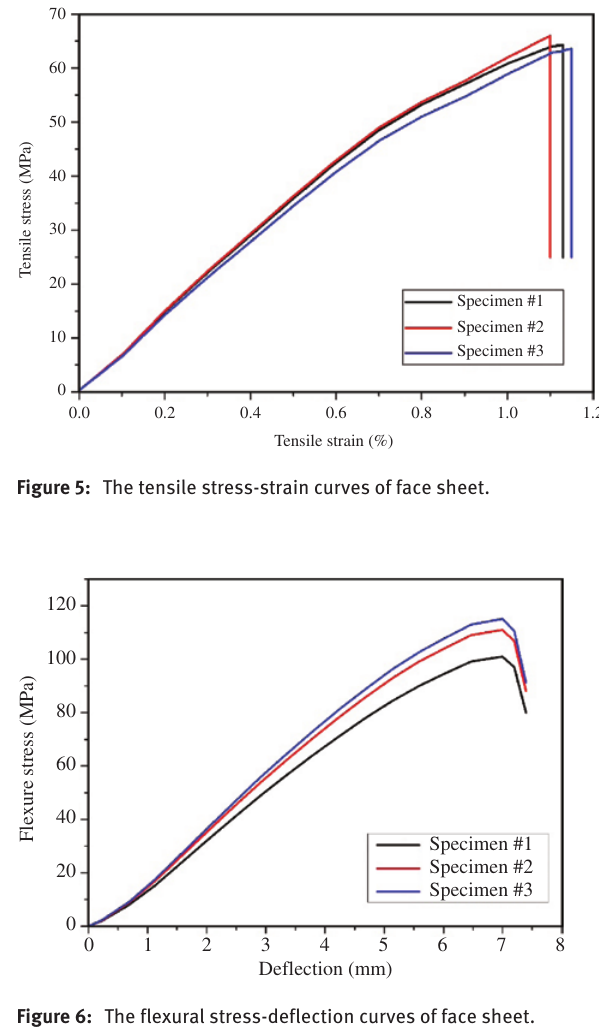
Figure 6: The flexural stress-deflection curves of face sheet.